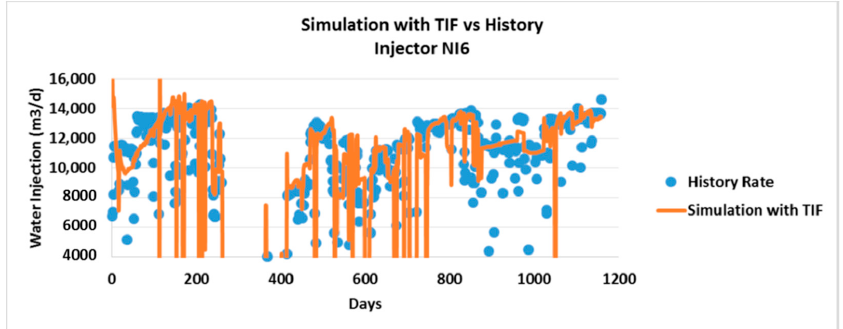
Figure 40. Final matched injection rate with TIF modelling after modifying the geomechanical and thermal properties.